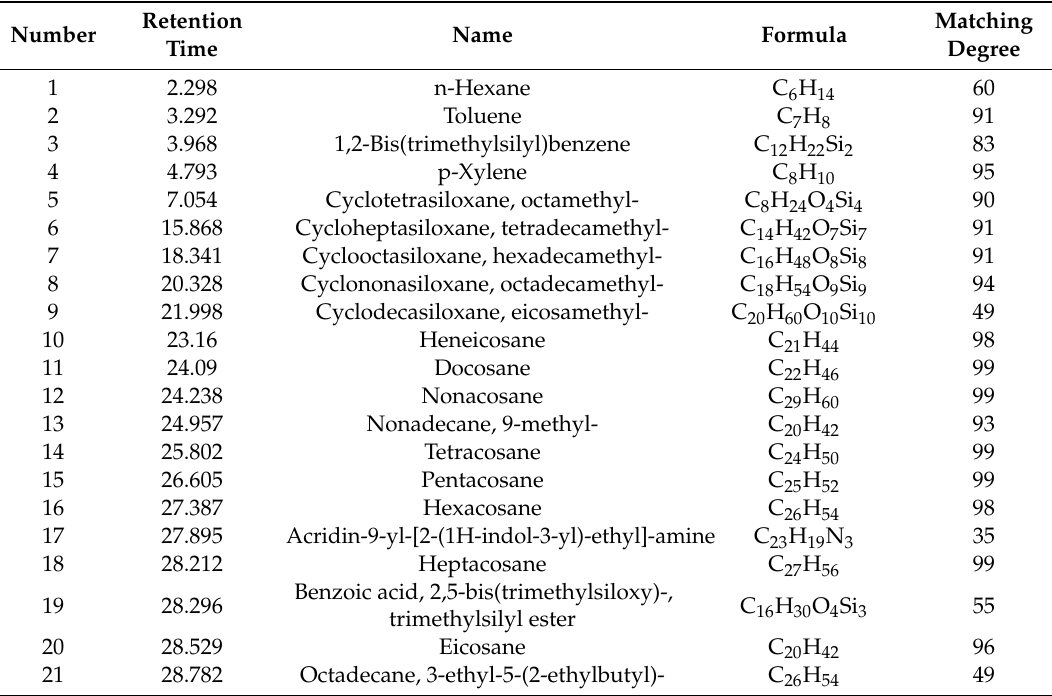
Table 4. Exhaust components absorbed by absorption liquid in conventional diesel combustion.